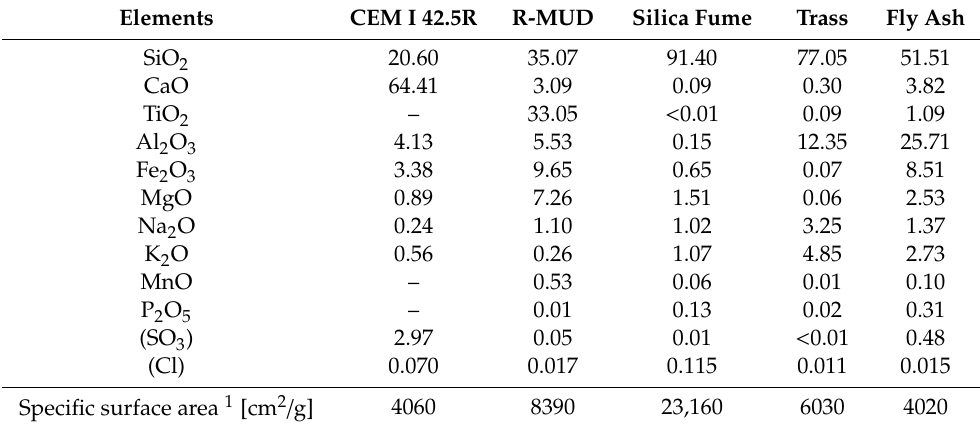
Table 1. Concentration [%] of major elements in samples and relevant